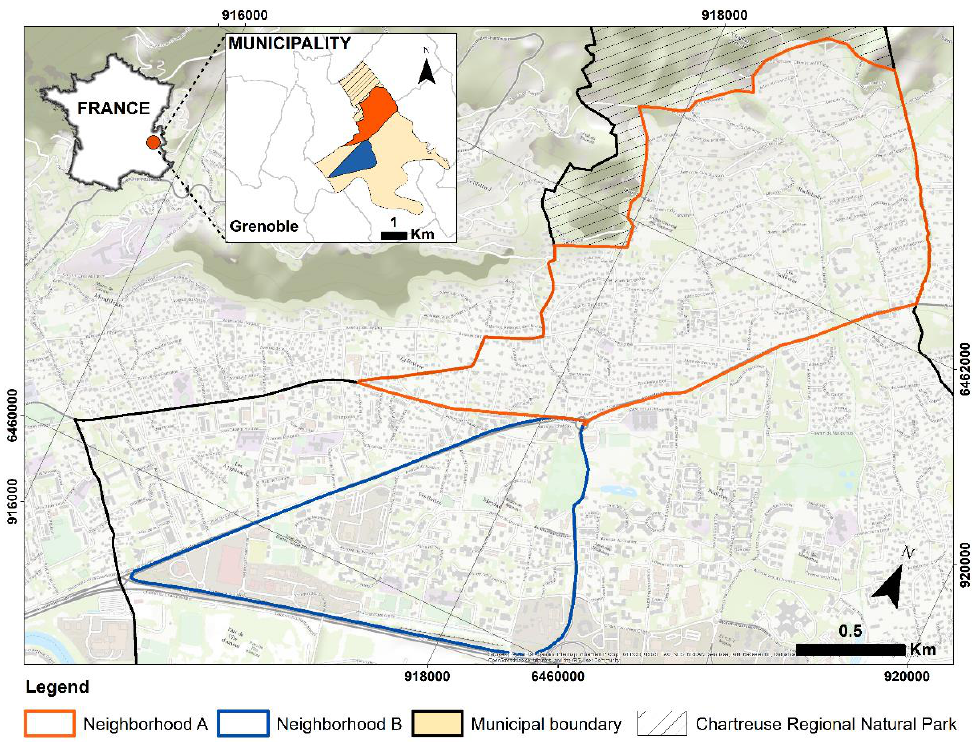
Figure 1. Location of the study areas. Maps created by the authors with ArcGIS 10.4 (https://www.esri.com/en-us/home, accessed on: 23 July 2021). Background image: Esri, Open- StreetMap.